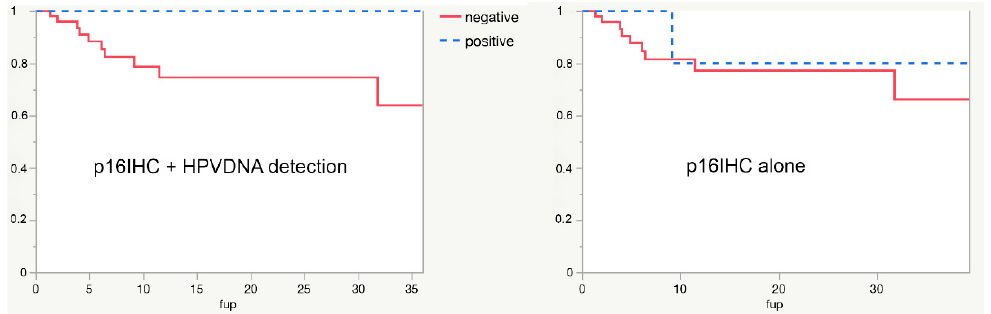
Figure 1. Survival curves in HPV-positive versus HPV-negative cases in the present series. When HPV-driven carcinogenesis is assessed by p16IHC alone (right panel), the power to predict survival is clearly